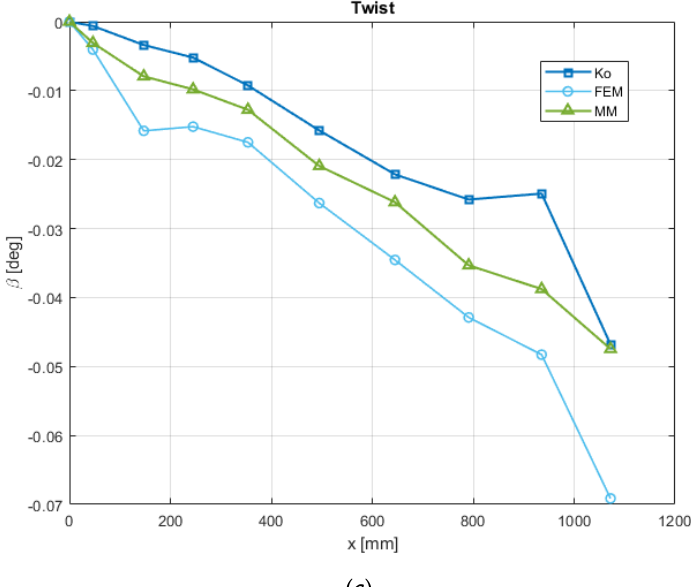
Figure 11. Result comparison between Modal Method (MM), Ko’s Displacement Theory (Ko), and FEM static analysis (FEM): ( a ) deflection along the first sensing line; ( b ) deflection along the second sensing line; ( c ) twist computed through the lines deflection.